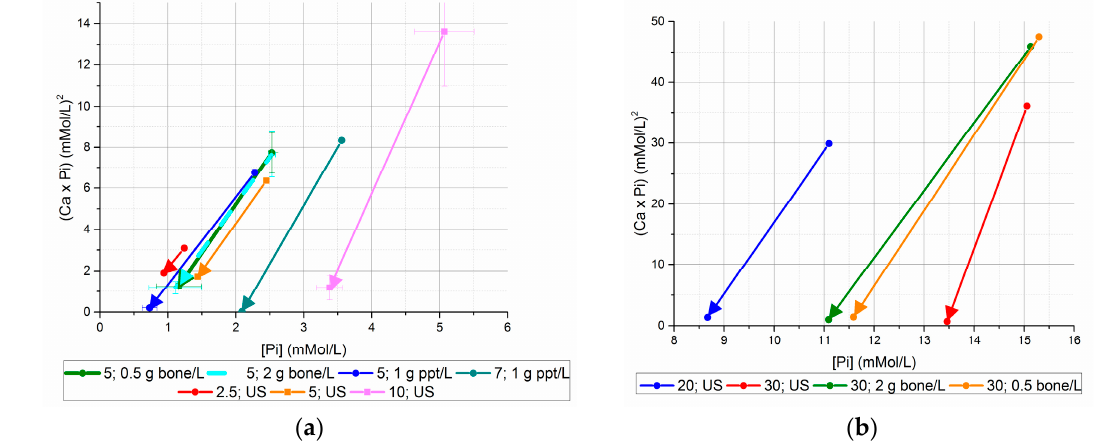
Figure 4. Initial and final (Ca × P) values, versus initial and final [Pi] (( a ) initial [Pi] < 20 mM, ( b ) initial [Pi] ≥ 20 mM). Using seed from previous unseeded experiments generated lower final [Ca 2+ ] × [Pi] values than bone mineral seed or no seed for equivalent initial [Pi].